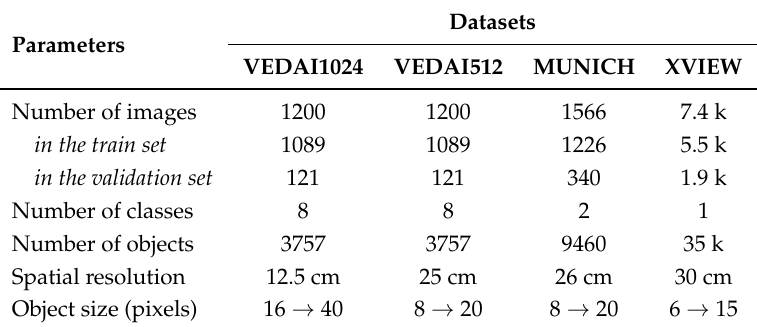
Table 2. Experimental datasets used in our